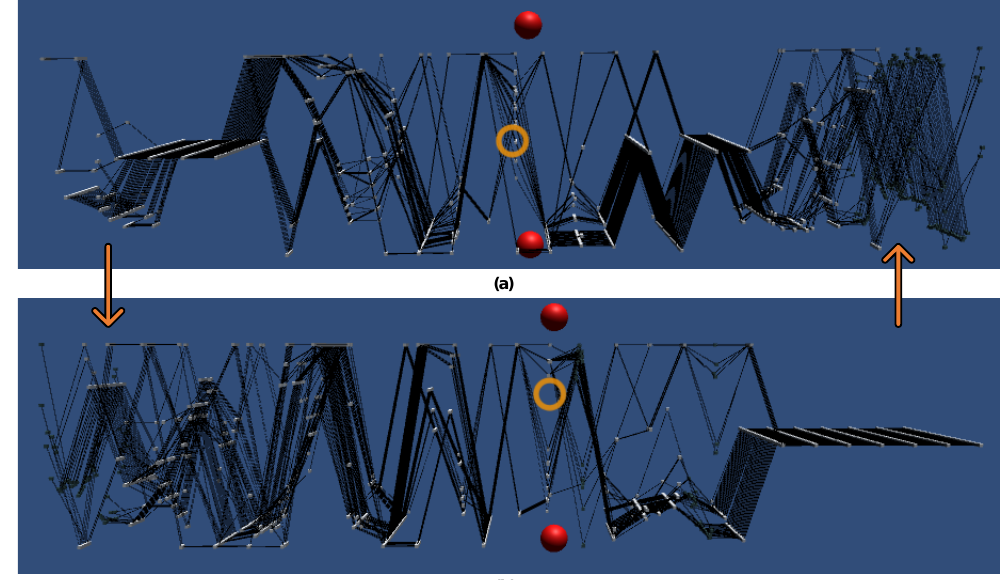
Figure 6. The IPCP visualization of the DS1 dataset presented in original ( a , b ) sorted order. The rearrangement of the axes was carried out based on the importances. As it can be seen in ( b ) the axes containing no knowledge i.e., constant data, were moved on the right of the IPCP main plot, thus reducing the amount of data that has to be visually analyzed by the user. The user can toggle between sorted and unsorted i.e., the original organization of the